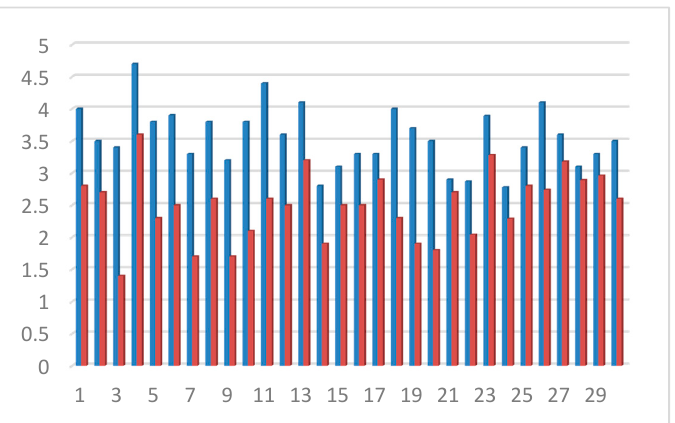
Figure 5. Average of the plaque index values before (T1) and after treatment (T3). Patients from 1 to 10 were included in group A, from 11 to 20 were in group B and from 21 to 30 were in group C. The total average decrease was 70.43%, with group A’s average decrease being 70.7%, group B’s average decrease being 79.8% and group C’s average decrease being 60.8%.